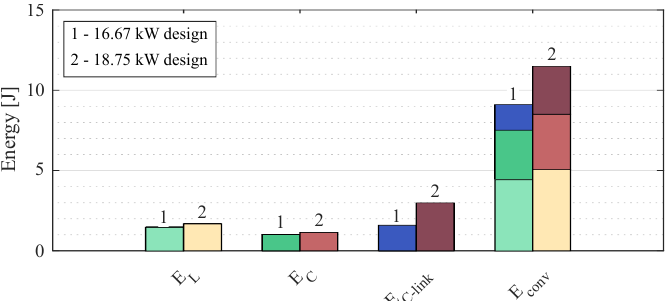
Figure 13. Comparison of the stored energy in the passive elements for 2L C converter configurations.